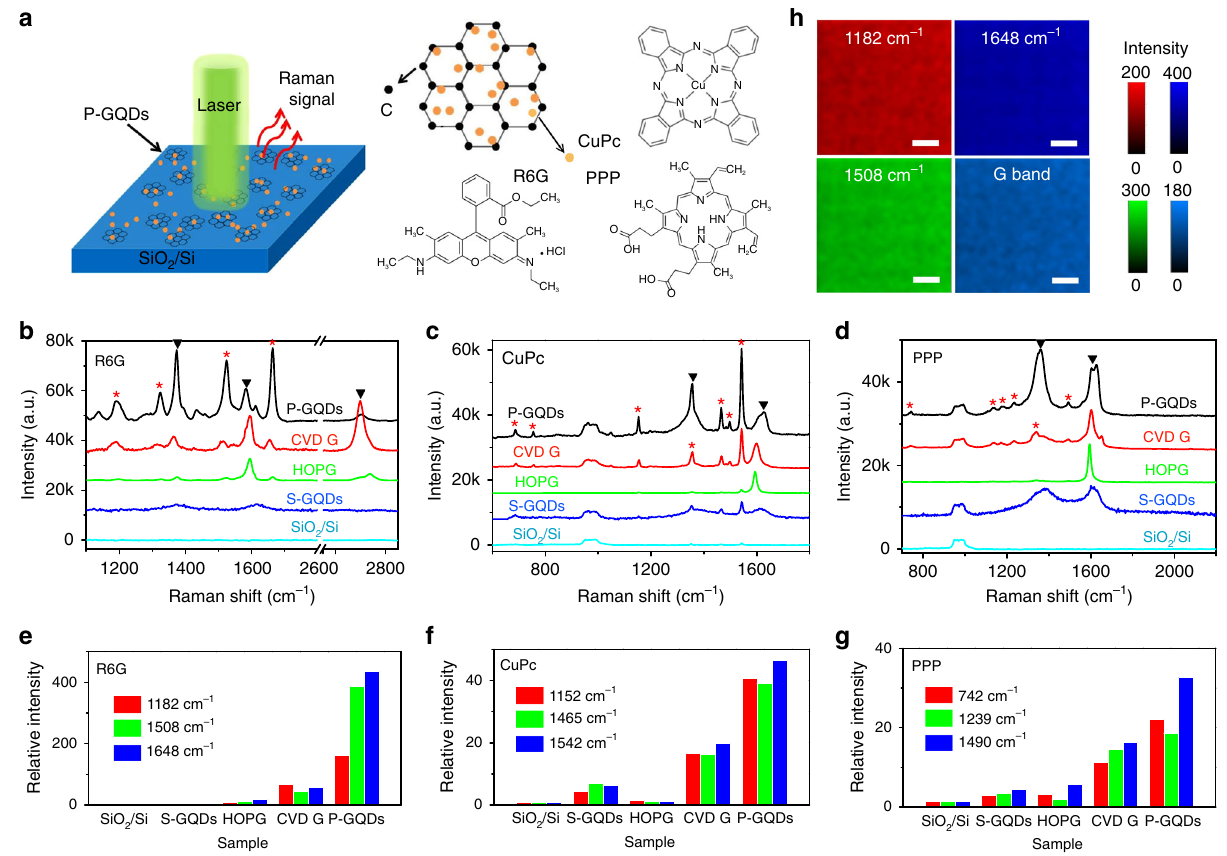
Fig. 3 Raman enhancement of thermally evaporated R6G, CuPc, PPP on P-GQDs. a Schematic of a P-GQD substrate for Raman measurement. b – d Raman spectra of thermally evaporated rhodamine 6G (R6G), copper phthalocyanine (CuPc) and Protopphyrin IX (PPP) on SiO 2 /Si, graphene quantum dots produced by solution processes (S-GQDs), HOPG, transferred chemical vapor depostion (CVD) graphene and P-GQDs, respectively. Black arrows indicate the peaks from graphene, and red stars indicate the peaks from the target molecule. e – g Relative intensity of the Raman signals of R6G, CuPc and PPP on different substrates, normalized to the signals on SiO 2 /Si. h Raman mapping of the intensity of the G band and the characteristic peaks of R6G on P-GQDs. The scale bars are 10 μ m in h . The unit of the colour bars are a.u. in